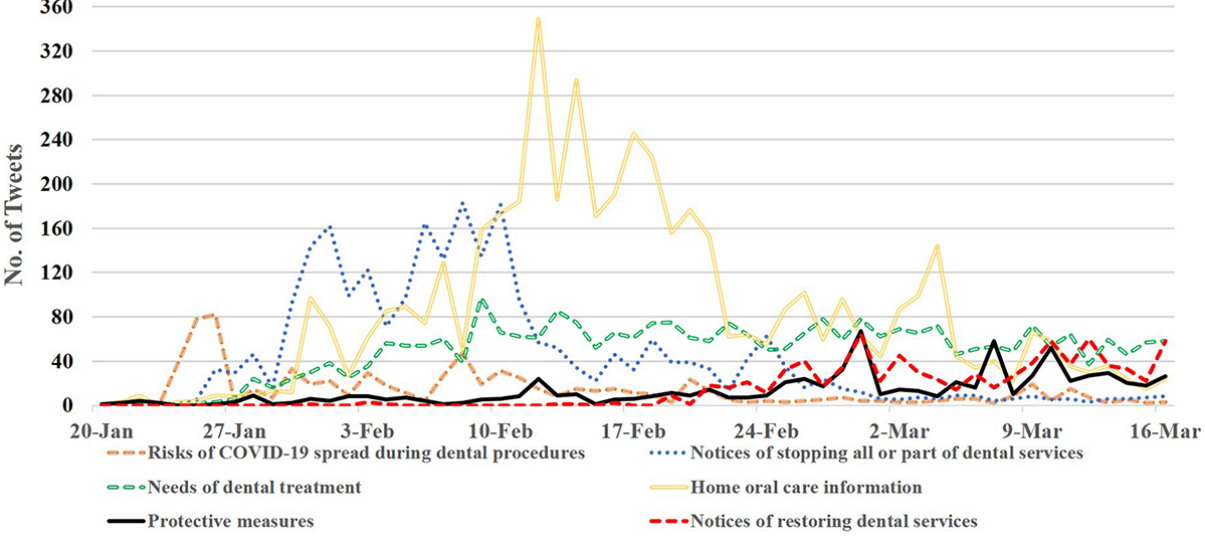
Figure 6. Time distributions of oral health–related tweets during the COVID-19 epidemic. COVID-19: coronavirus disease.